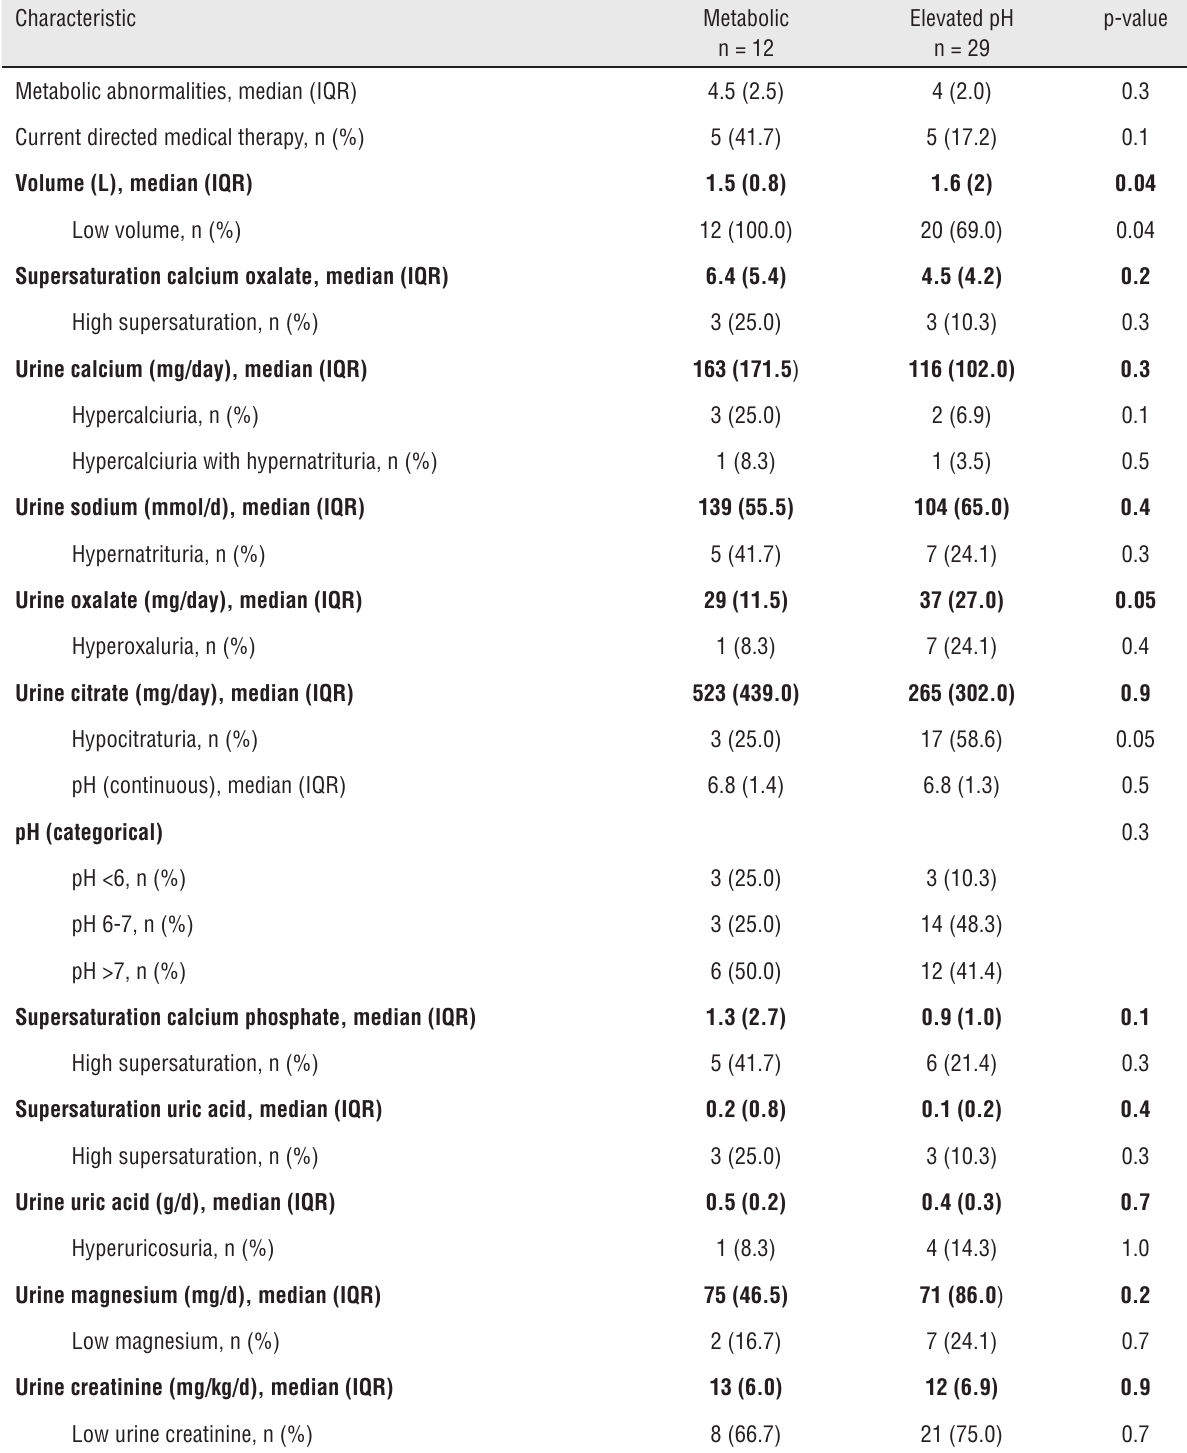
Table 2 - Urinary metabolic parameters by primary calculus